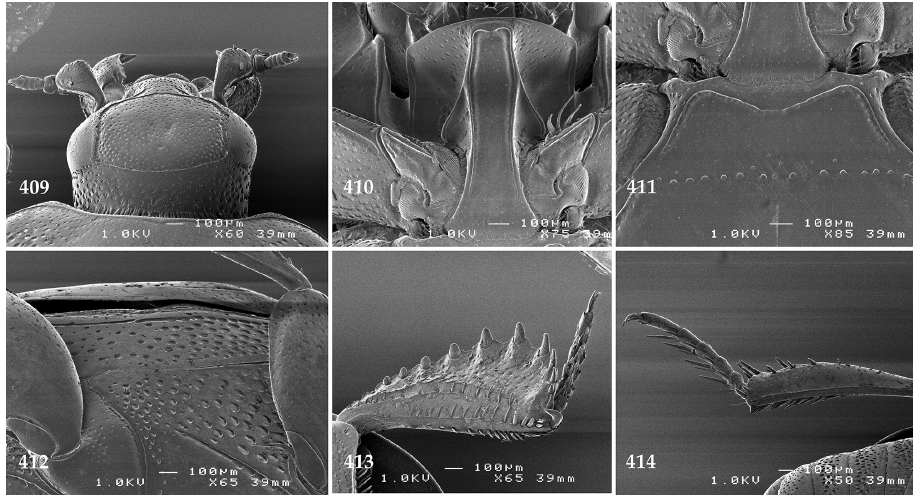
ternum 411 mesoventrite 412 lateral disc of metaventrite + metepisternum 413 protibia, ventral view 414 metatibia, ventral